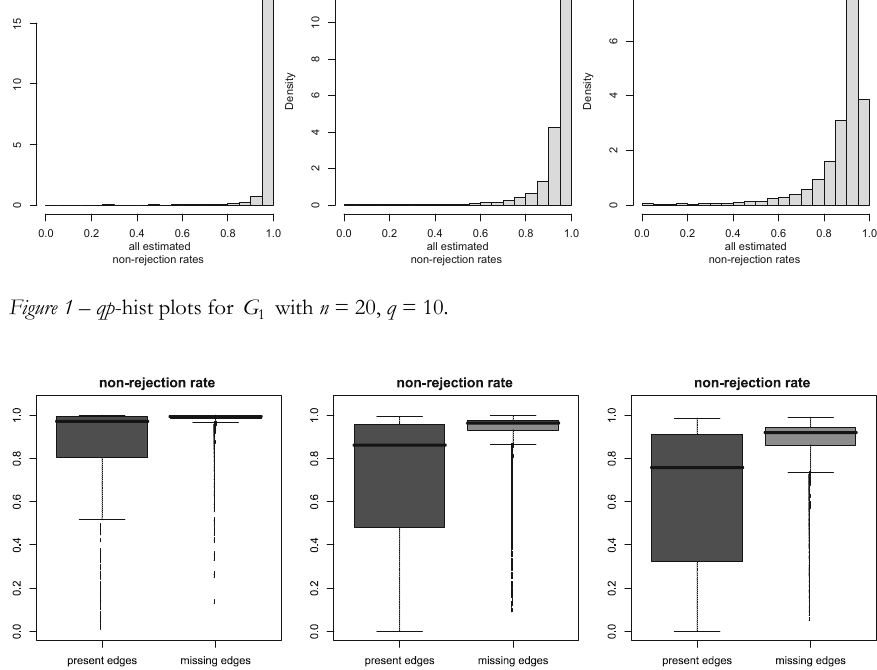
Figure 2 – Boxplots with the distribution of the non-rejection rate for present and missing edges of G to be associated to the corresponding histograms in Figure 1